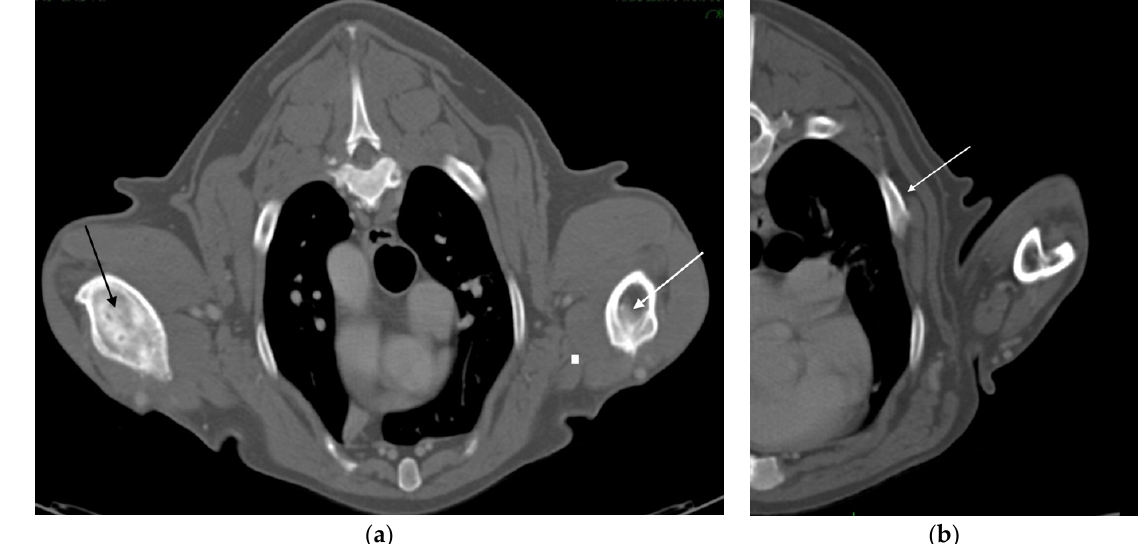
Figure 4. ( a ) Transverse CT image, six years after the first admission, shows a severe lysis of the right diaphyseal humerus (black arrow). On the contralateral humerus, outcomes of a previous osteomyelitis are observed, with considerable thickening of the cortex (white arrow). ( b ) Thorax transverse CT reconstruction shows focal costal thickening attributable to hyperostosis (white arrow).